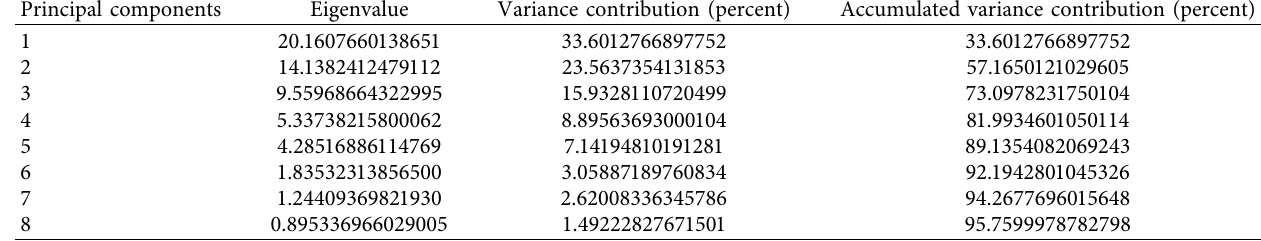
Table 2: The first eight principal components’ eigenvalue and variance contribution by PCA in one computation.